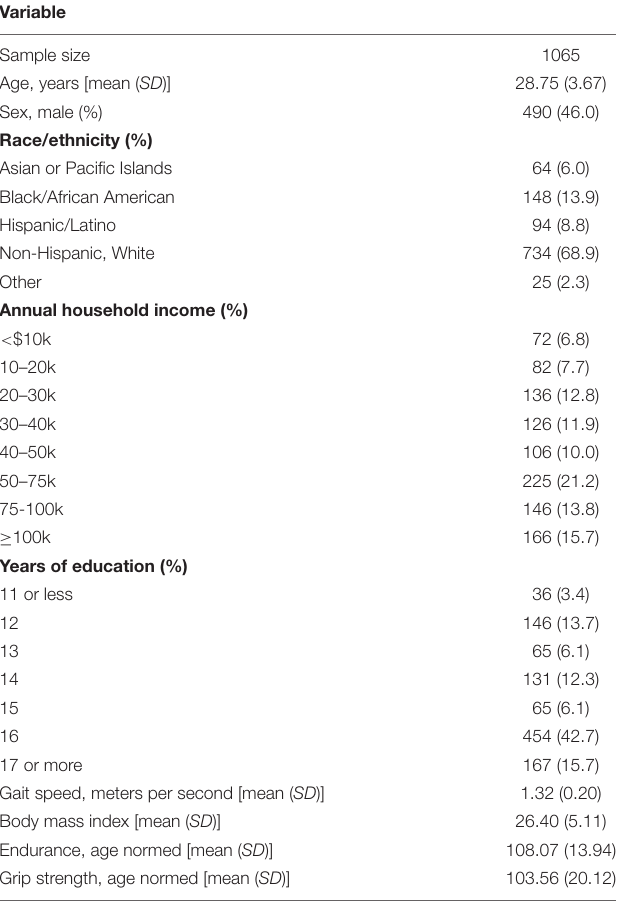
TABLE 1 | Descriptive information on total sample.